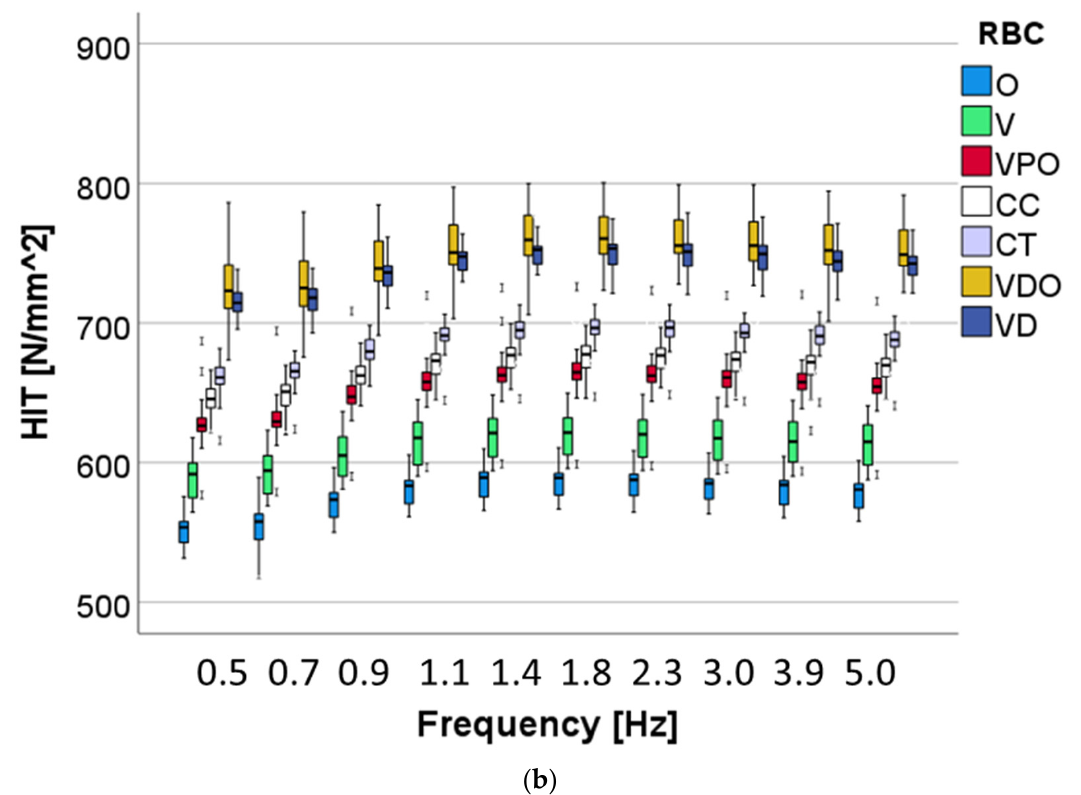
Figure 9. Variation of the indentation hardness as a function of material and frequency in ( a ) unaged and ( b ) after 6 months’ immersion in artificial saliva.